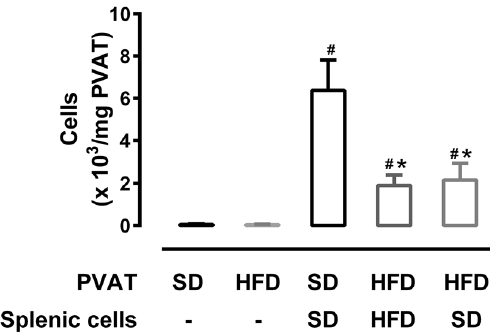
Figure 4. Splenic cell chemotaxis mediated by mesenteric PVAT (mPVAT) was reduced in mice fed a high- fat diet (HFD). Migration of splenic cells from SHAM mice fed with standard diet (SD) or HFD towards their respective mPVAT. Another set of experiments was performed with PVAT from mice fed with HFD using spleen cells from mice fed with SD. Control conditions involved placing only PVAT in the lower compartment. Results from two different experiments (n = 6 to 9 per group). Data were expressed as mean ± SEM. ANOVA: * P < 0.05, versus